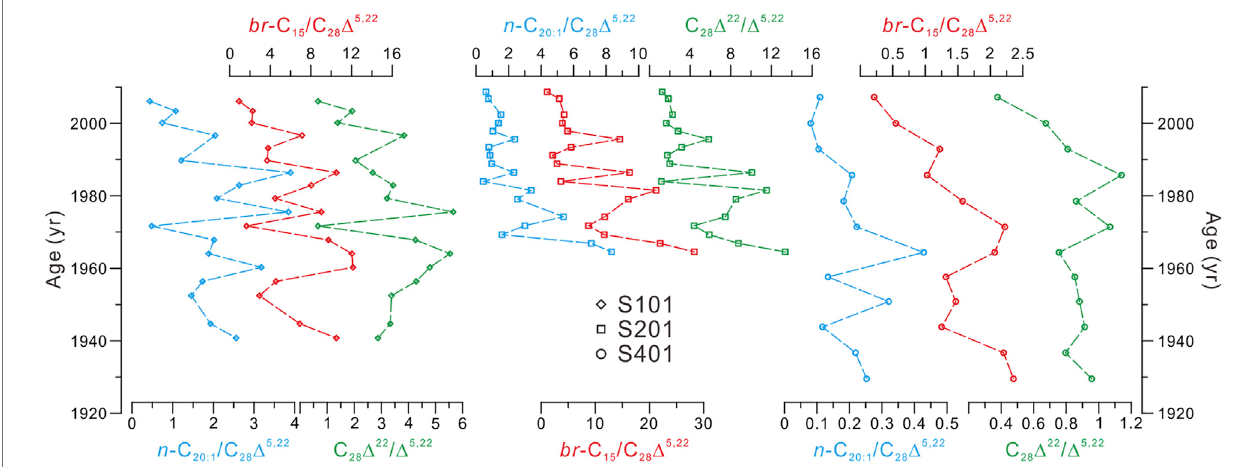
FIGURE 8 | Comparison of n -C 20:1 /C 28 Δ 5,22 (blue curves) and br -C 15 /C 28 Δ 5,22 (red curves) with C 28 Δ 22 / Δ 5,22 (green curves) in the three cores.